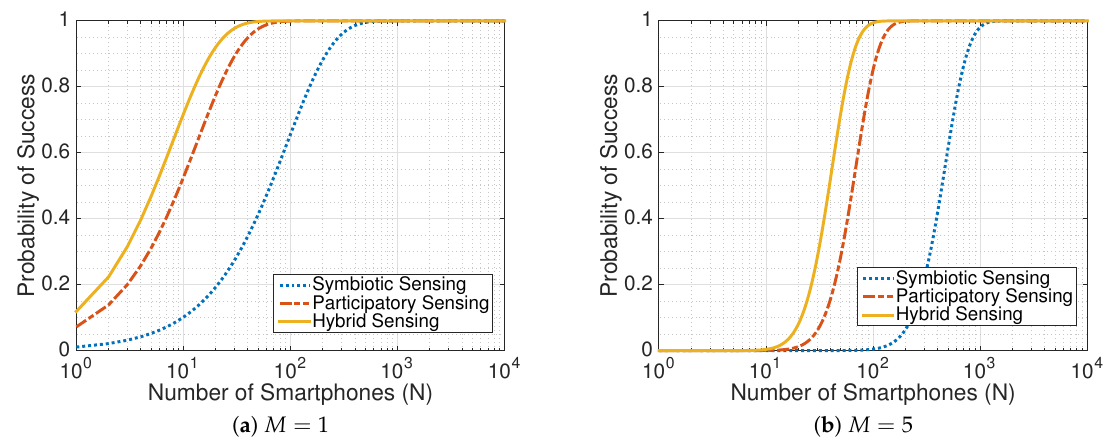
Figure 7. Evaluation of the Ear-Phone [47] city noise map application in terms of the success probability when applying participatory sensing (original work), symbiotic sensing, and hybrid sensing with different minimum required observations: ( a ) M = 1; ( b ) M =